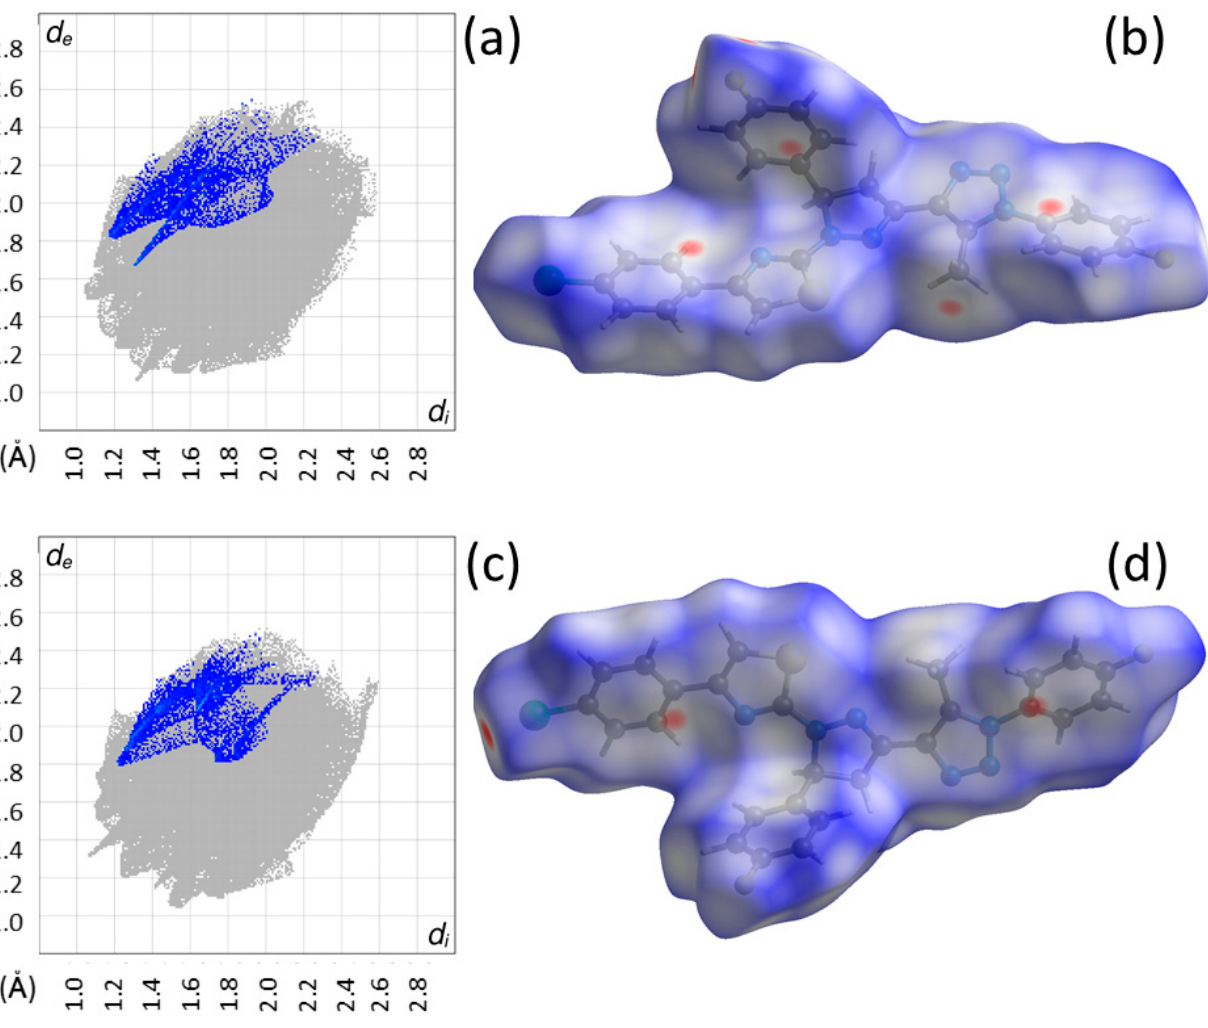
Figure 6. ( a ): Two-dimensional fingerprint plot for one independent molecule of 4 with Cl interactions highlighted; ( b ): the associated Hirshfeld surface. ( c ): Two-dimensional fingerprint plot for the second independent molecule with Cl interactions highlighted; ( d ): the associated Hirshfeld surface.